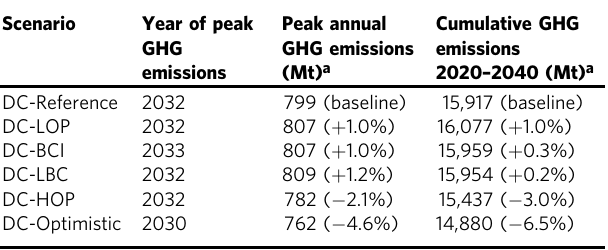
a The percentage in parentheses represents the difference between that scenario and the DC- reference